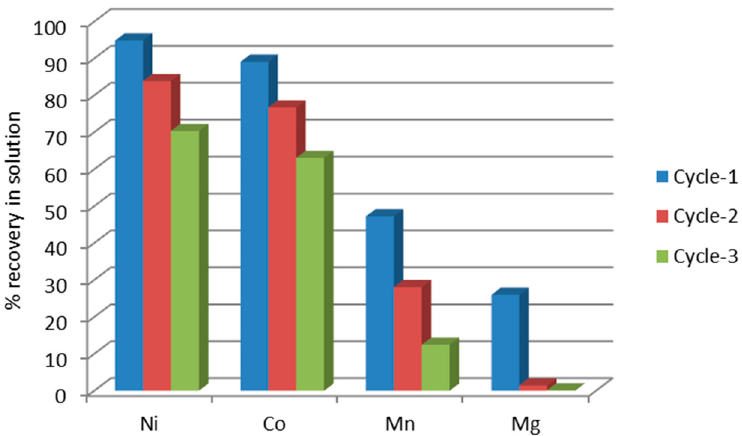
Figure 8. Percent recovery of Ni, Co, Mn, and Mg in the aqueous solution, after three repetitive cycles of AO and AD steps.